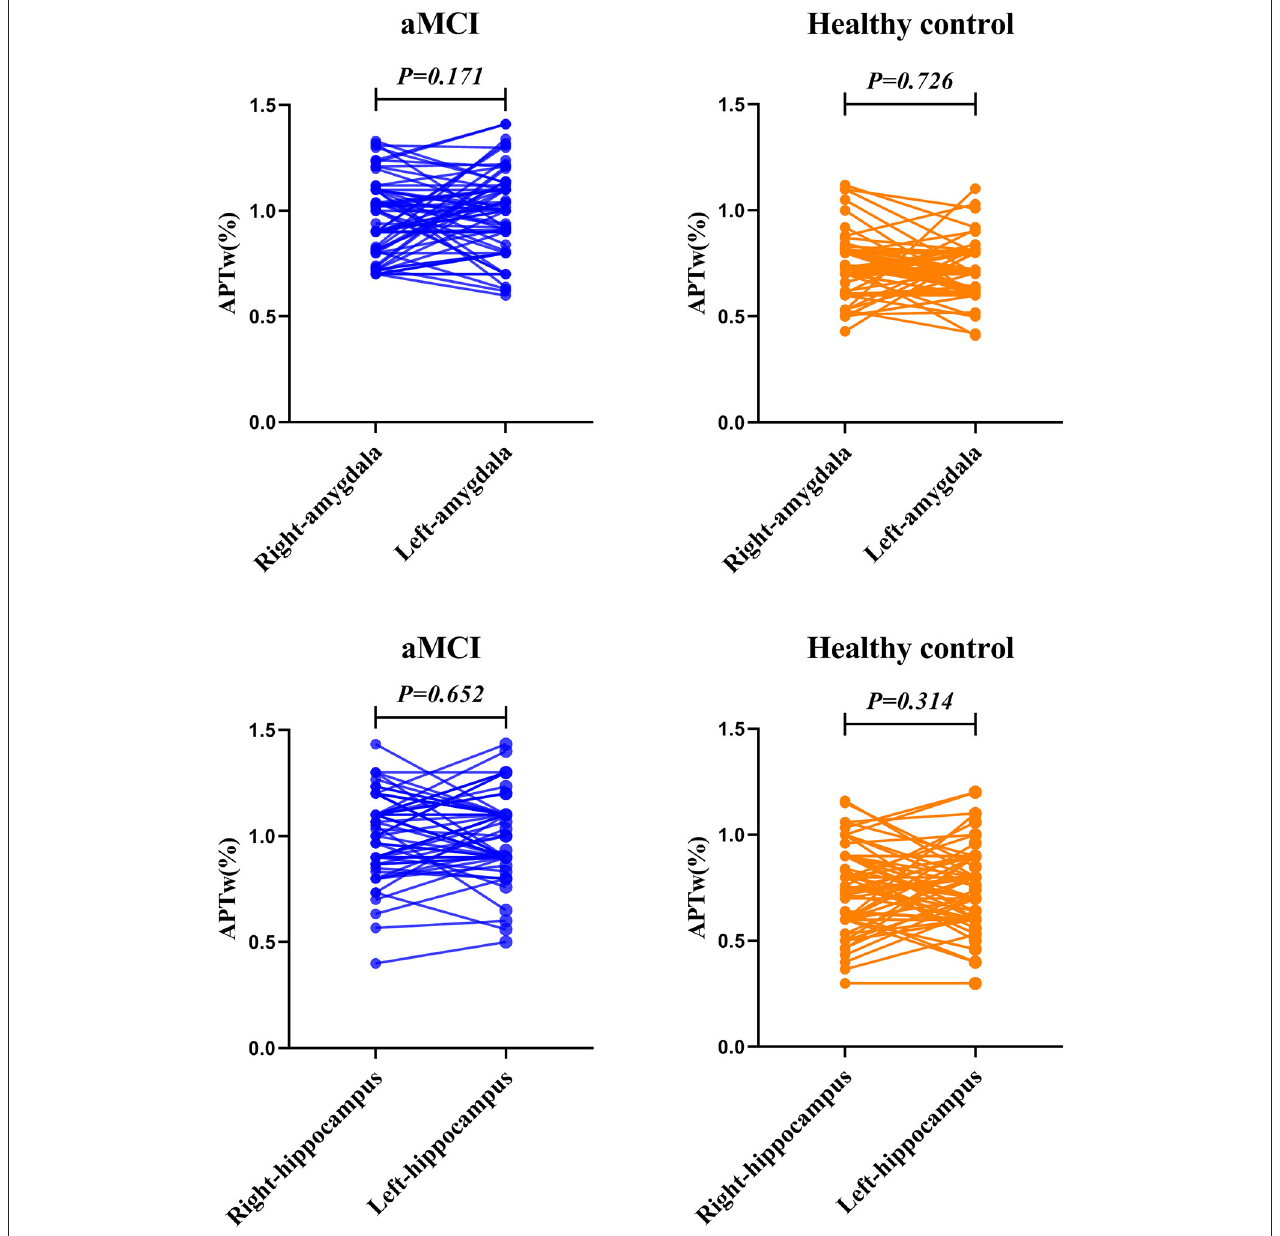
FIGURE 3 | The paired t -test for the APTw value of the bilateral amygdala and hippocampus. The results are shown from the regions of interest (ROIs) in aMCI (blue) group and the healthy control (orange).